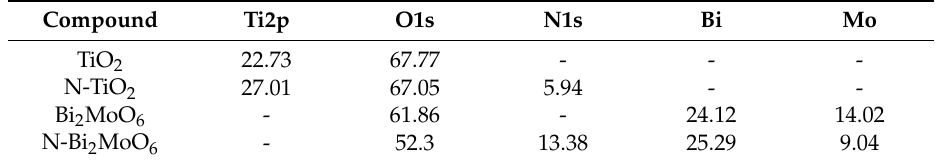
Atomic percent values from XPS analyses for TiO 2 , Bi 2 MoO 6 , N-TiO 2 , and N-Bi 2 MoO 6 catalysts.